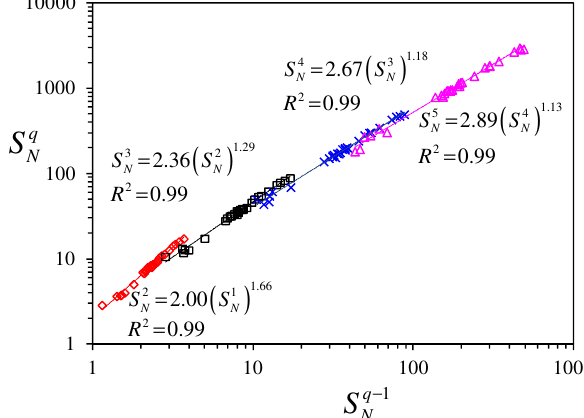
− 1 of Arizona data with S q for 2 N N